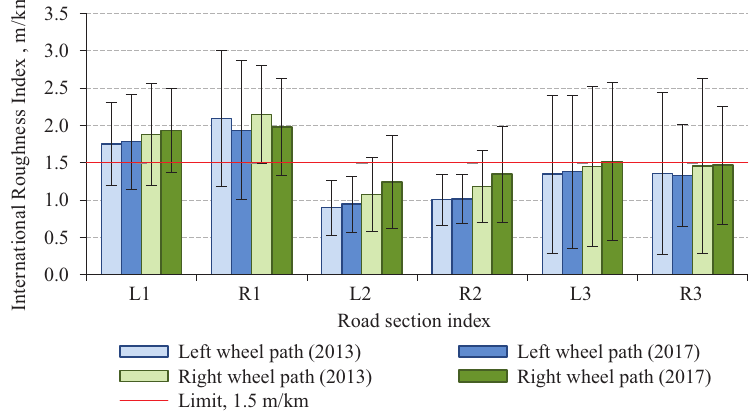
Figure 3. Mean of International Roughness Index in 2013 and